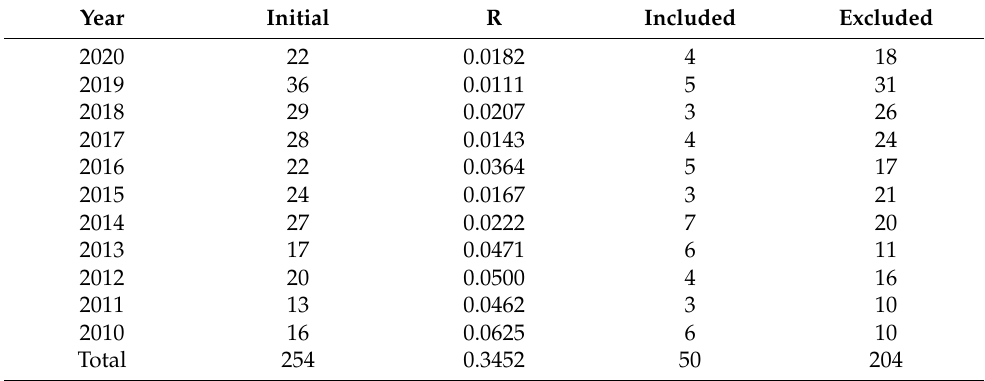
Table 2. The included and excluded relevant papers per publication